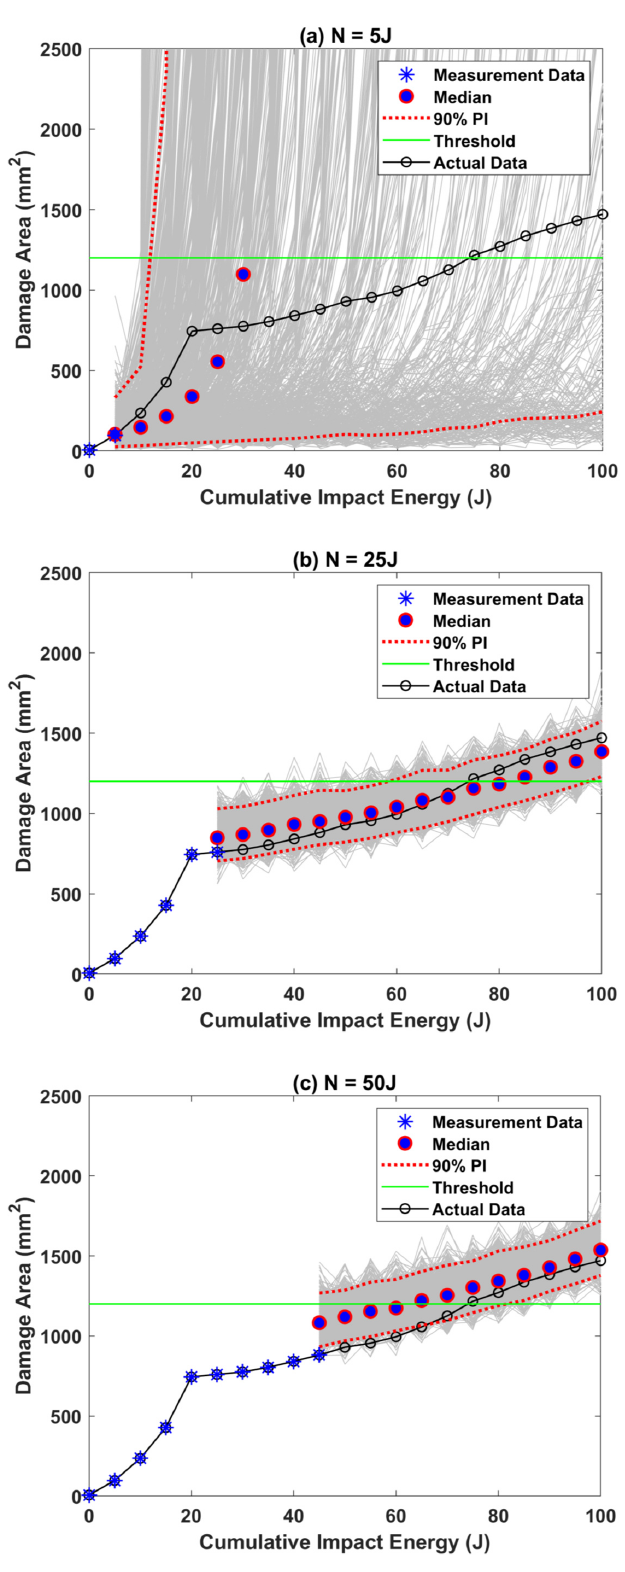
Figure 4. The prediction results for delamination 1 of sample S1 using the Paris–Paris model with failure threshold assumed to be at 1200 mm 2 . The grey lines represent the particle trajectories for 1000 particles in the particle filter